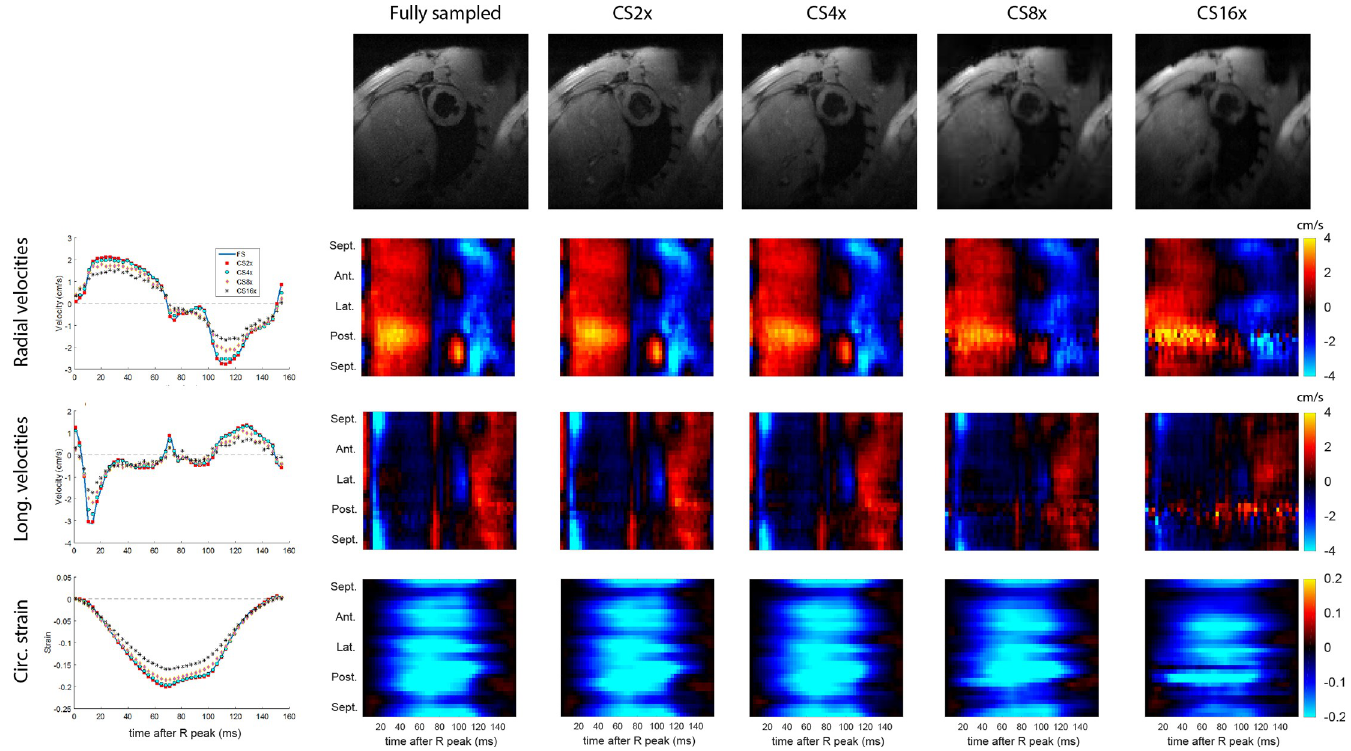
Fig 3. Retrospective CS results from a representative non-infarcted heart. Direct comparisons of magnitude images (1 st row) as well as the transmural average of global and regional radial velocities (2 nd row), longitudinal velocities (3 rd row), and global circumferential strain values (4 th row), for a variety of undersampling factors.